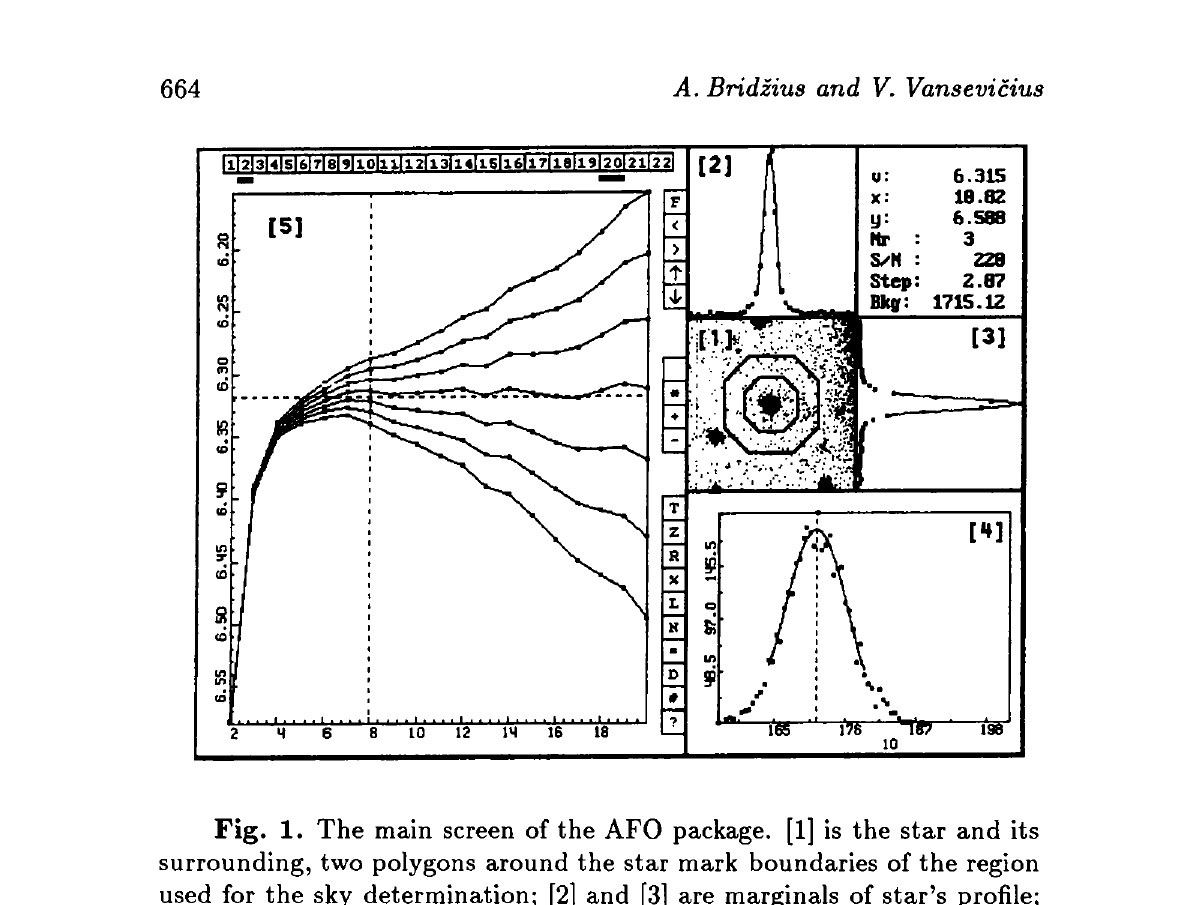
Fig. 1. The main screen of the AFO package. [1] is the star and its surrounding, two polygons around the star mark boundaries of the region used for the sky determination; [2] and [3] are marginals of star's profile; [4] is a histogram for the sky determination; [5] are the growth-curves of the star: the number of the aperture is on the X-axis and the instrumental magnitude is on the